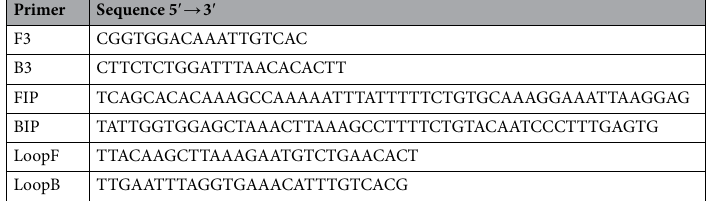
Table 2. SARS-CoV-2 RT-LAMP primer set used in the optimized RT-LAMP